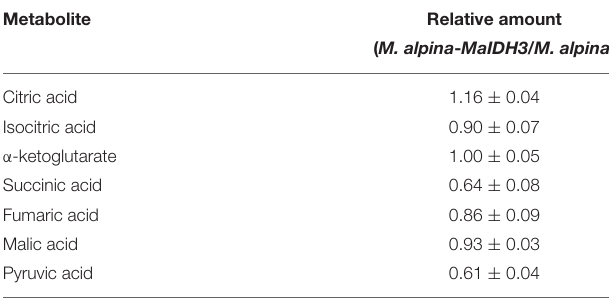
TABLE 3 | Changes in related metabolite of NAD + -MaIDH recombinant strains.